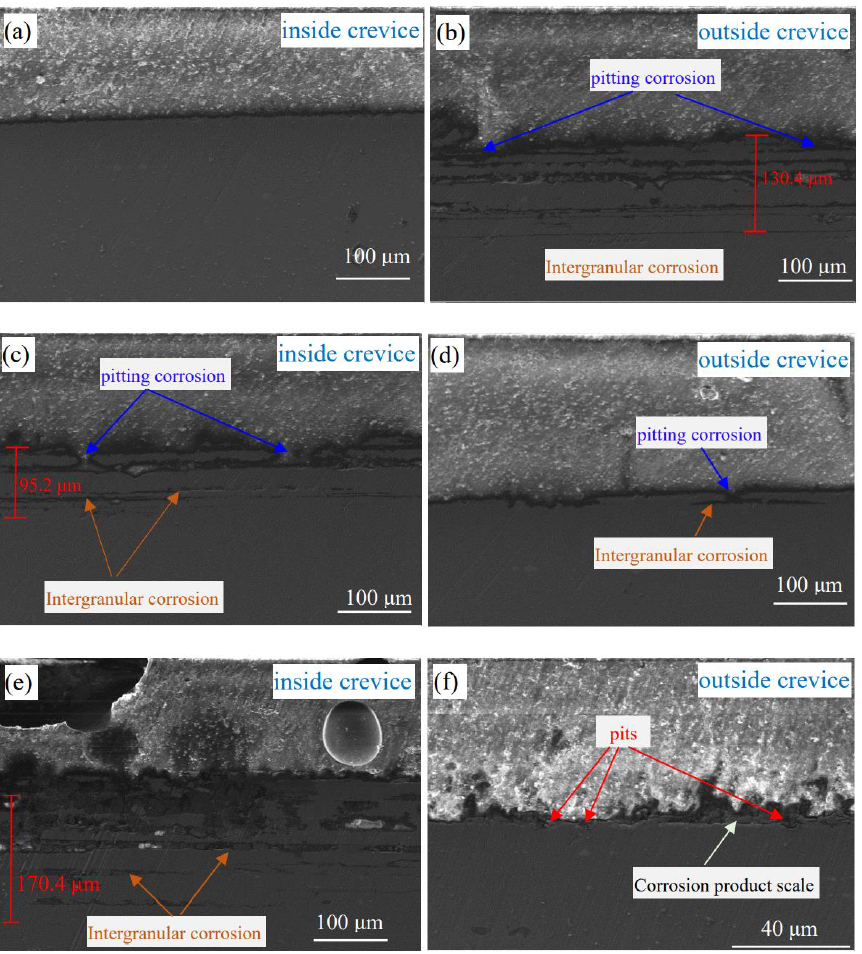
Figure 9. The cross-section of specimens inside and outside crevice in solution with different con- centrations of NaNO 3 after corrosion for 24 h, ( a , b ) 0 wt.% NaNO 3 , ( c , d ) 0.2 wt.% NaNO 3 , ( e , f ) 0.5 wt.% NaNO 3 .